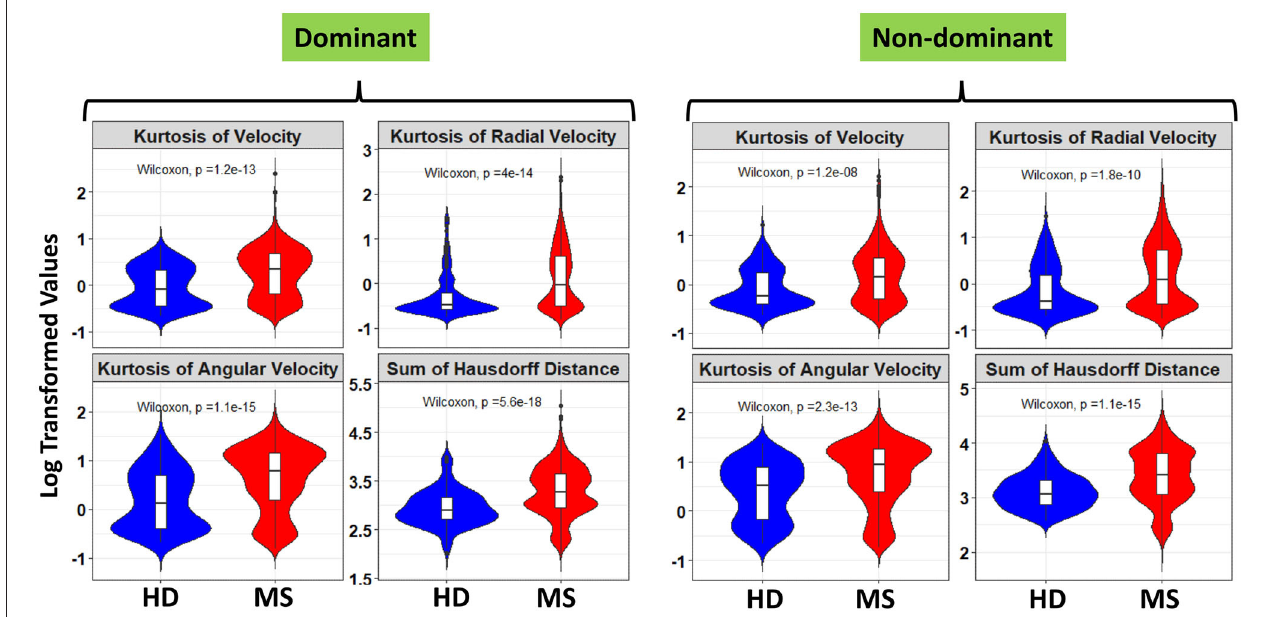
FIGURE 5 | Violin and boxplot of the selected spiral-derived features with FC > 2 and ICC > 0.5 with respect to healthy donors and patients with MS at the difficulty level 1. The blue color indicates the healthy donors while red shows the patients with MS. There were multiple tests per subject in the HD and MS group. Values are shown using a bi-symmetric log transformation for both the dominant and non-dominant hand (The p indicates the p -value of the unpaired Two-Samples Wilcoxon test for the mean comparison of HD and MS groups).